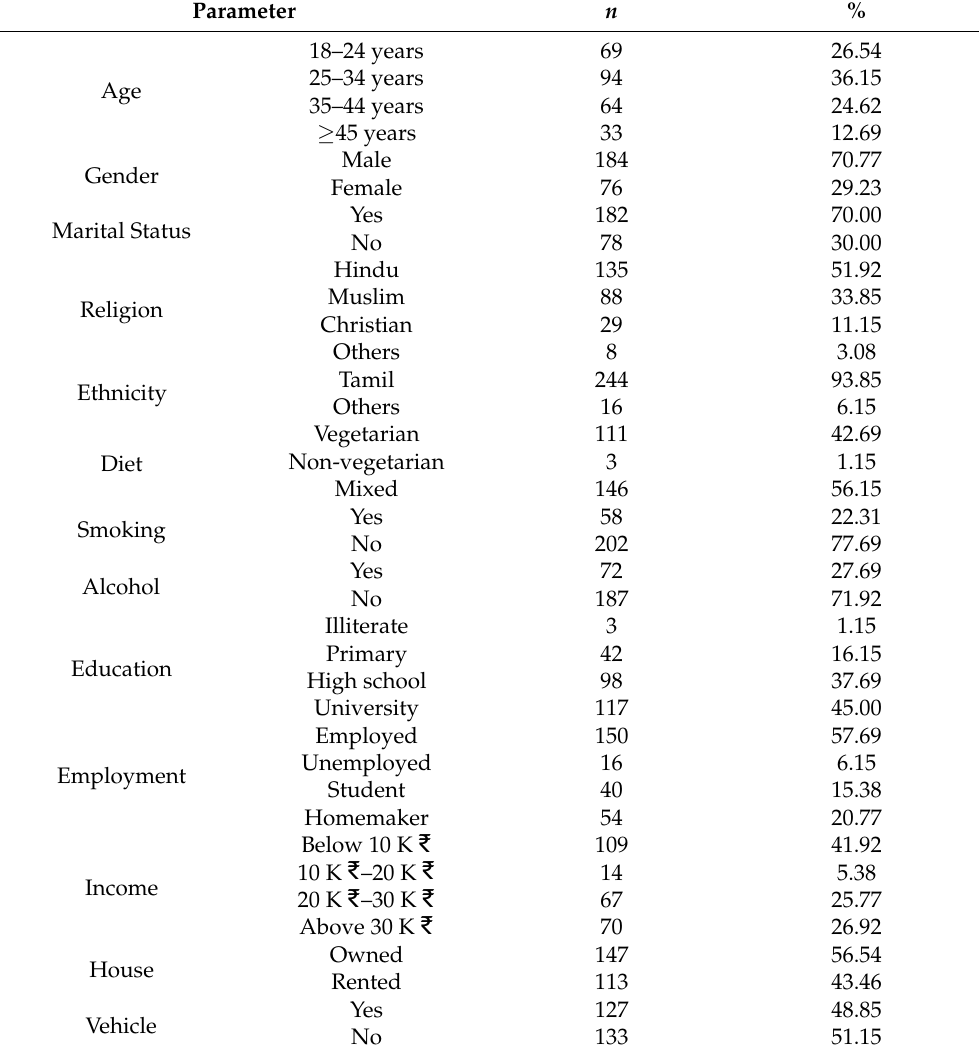
Table 3. Socio-demographic characteristics of study population ( n = 260). Parameter